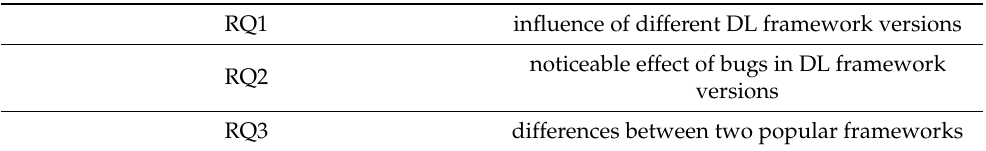
Table 2. List of objectives to address in this work that affect the performance of a DL-based code or its resulting model’s